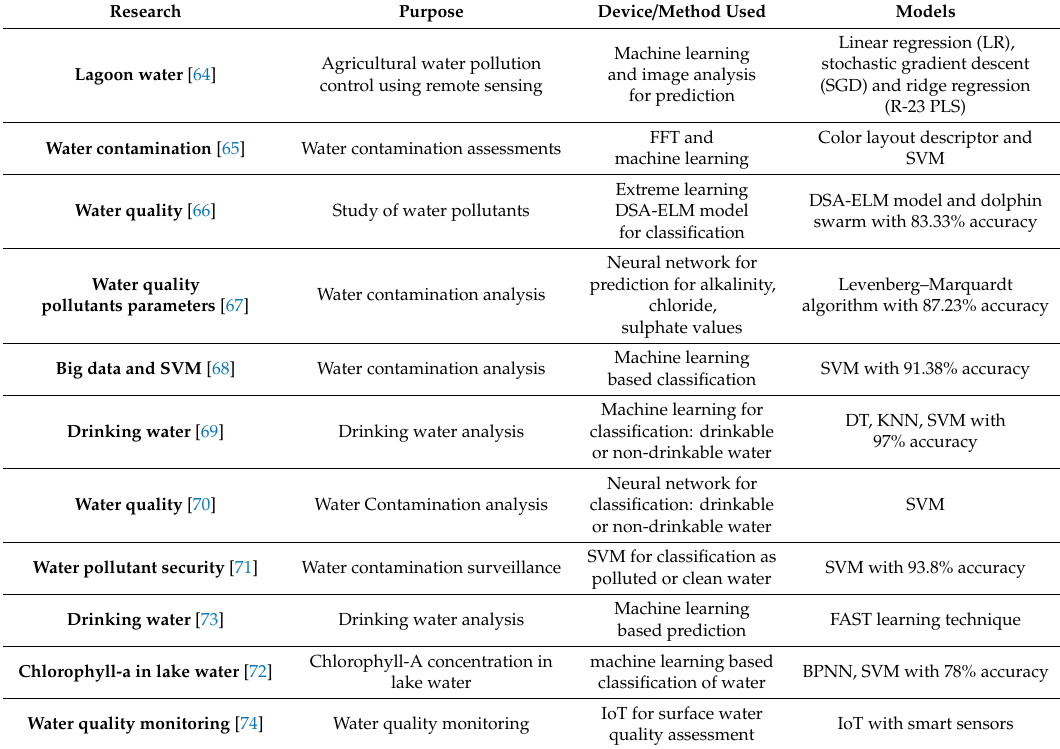
Table 3. Research on IoT based smart water pollution monitoring systems